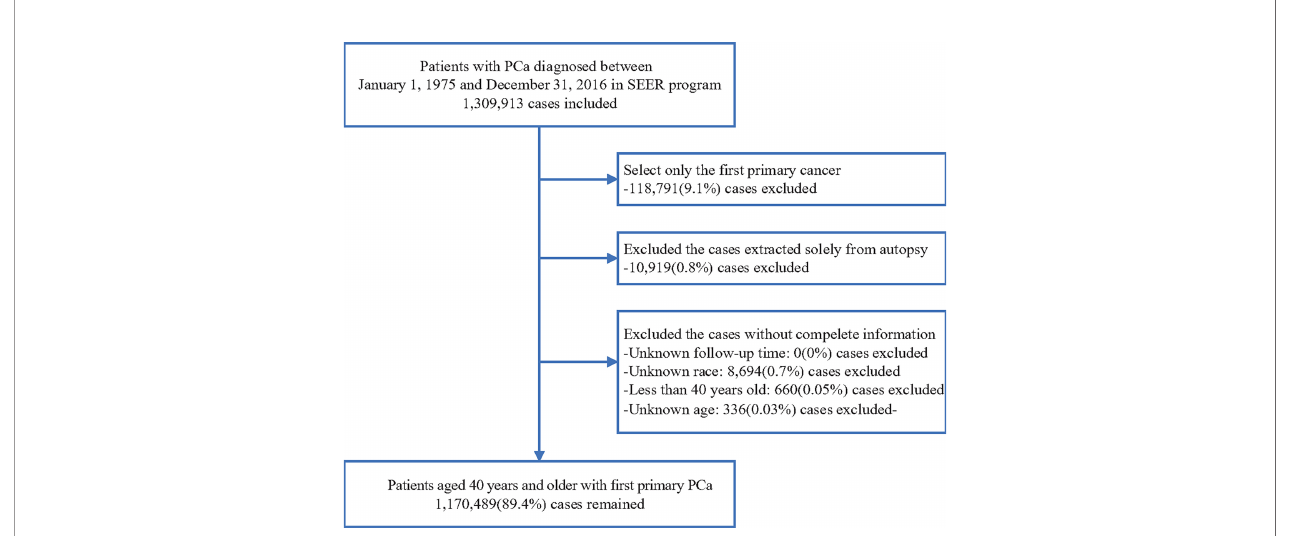
FIGURE 1 | Flow chart of case inclusion and exclusion